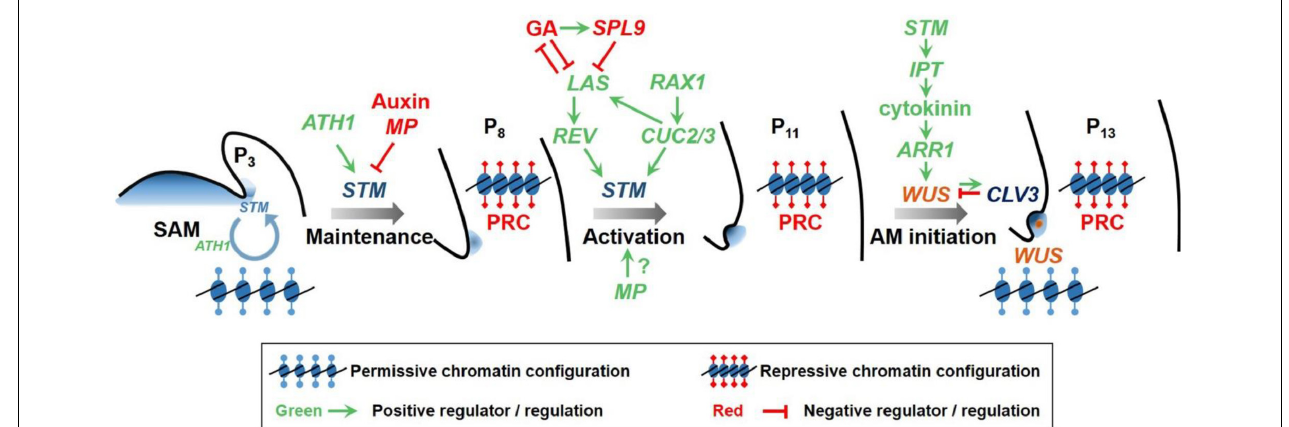
FIGURE 1 | A conceptual model of the two-step regulation of AM initiation. Low levels of STM expression is maintained in early leaf primordium (P 3 ) axils to reserve the competence of leaf axil cells to form AMs. High levels of auxin as well as unleashed auxin signaling (represented by MP ) suppress STM expression and cell competence. In more mature leaf primordia (P 8 ), the expression of REV , which is regulated by LAS , up-regulates STM expression to promote AM initiation. GA suppresses LAS expression through the action of SPL9, and vice versa , LAS suppresses GA biosynthesis. In parallel, RAX1 promotes CUC2/3 expression, which in turn activates STM and LAS expression. STM promotes cytokinin biogenesis, which, during the AM initiation stage, then activates WUS expression de novo through type B-ARRs to enable stem cell specification and axillary bud formation. WUS activates the expression of the secreted peptide CLV3 , which in turn downregulates WUS expression through the Leucine-rich repeat receptor kinase CLV1. Epigenetic modification is involved in restricting gene expression in the leaf axil. In each part of the diagram, the red inhibition symbols indicate transcriptional repression, and the green arrows indicate transcriptional activation. Modified from Wang and Jiao (2018).